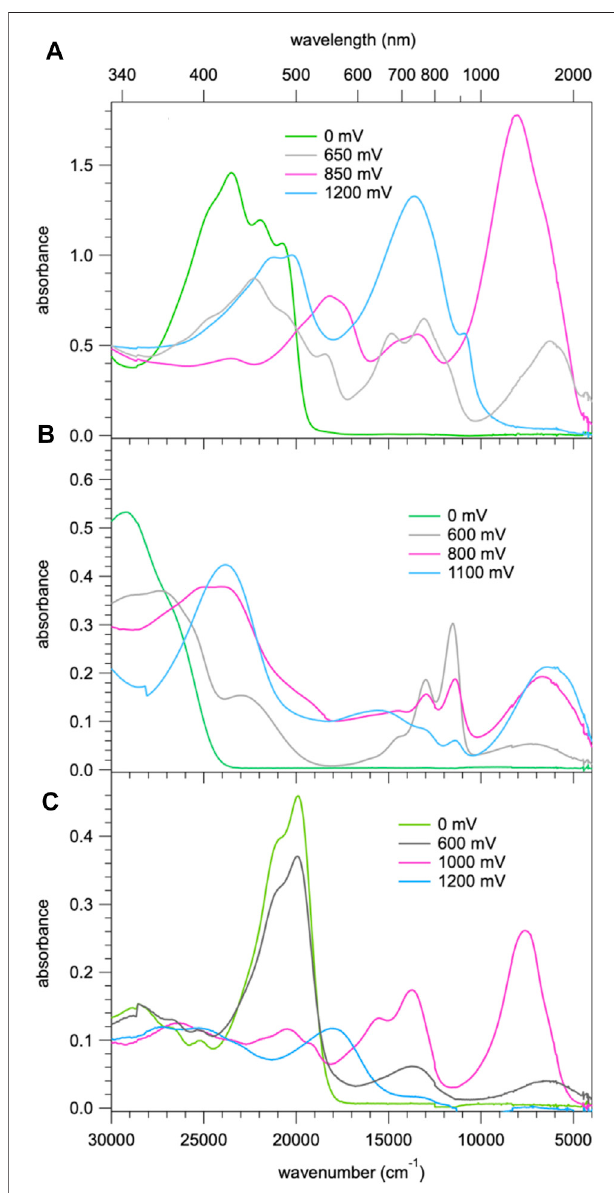
FIGURE 6 | (A) Absorption spectra of 1 corresponding to the fi rst three oxidation steps with the most probable spectra of the three species extracted fromthespectraof Figure4 ; (B) absorptionspectraof 2 correspondingtothe fi rst three oxidation steps with the most probable spectra of the three species; (C) absorption spectra of 3b corresponding to the three species on sequential